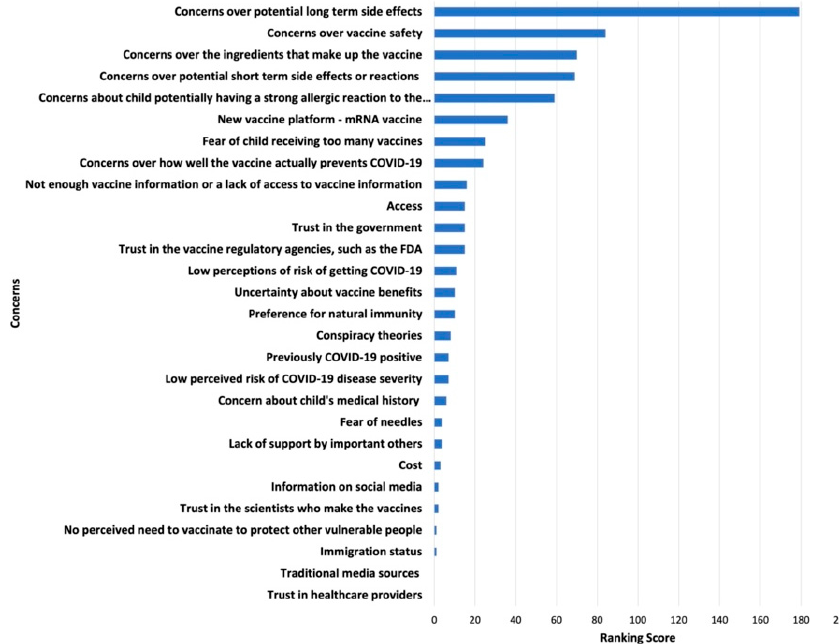
Figure 1. Top Parental Concerns for Vaccinating Adolescents against COVID-19.